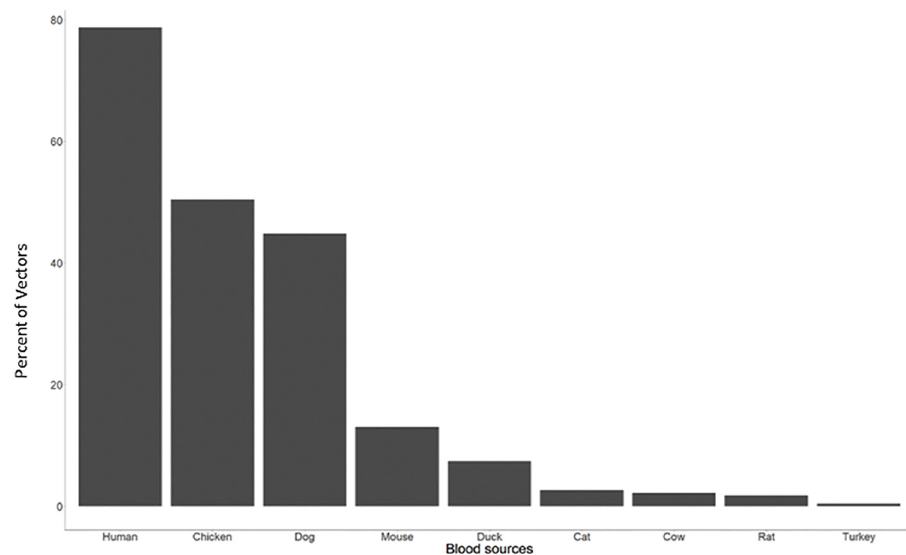
Fig 3. Percent of bugs with each blood source for bugs collected in Anonito, Jutiapa, Guatemala. Total percentage is over 100 because the average blood sources per bug was